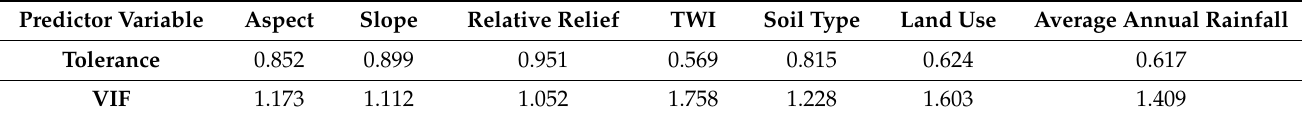
Table 2. Multi-Collinearity Analysis of the selected Predictor